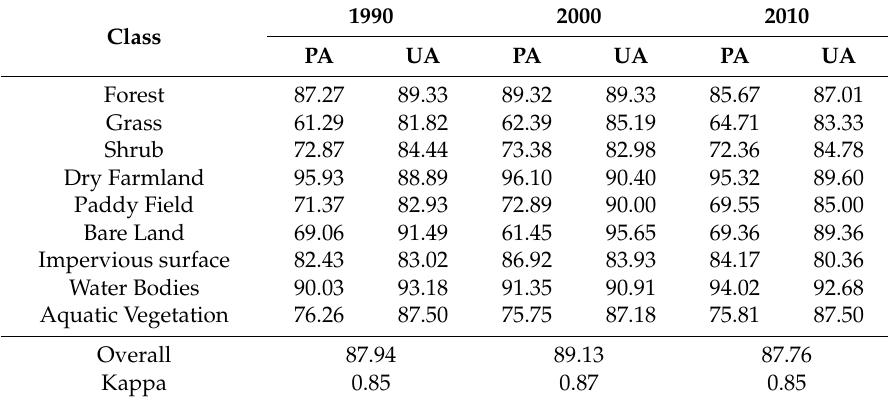
Table 2. Adjusted accuracy assessment of the classifications for the three periods. “Overall” is the overall accuracy, “Kappa” is the Kappa coefficient, “PA” is the producer’s accuracy and “UA” is the user’s accuracy. 1990 2000 Class PA UA PA